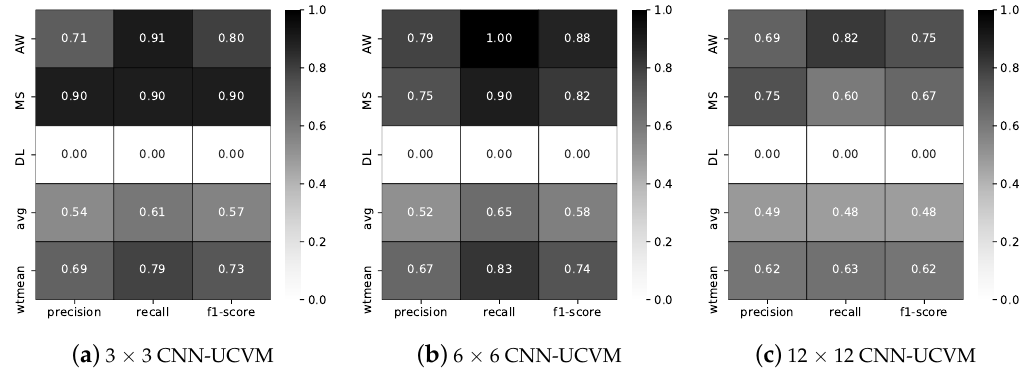
Figure 10. Validation statistics using field based vegetation observations for the CNN models trained using the UCVM dataset. (AW: Alder-Willow Shrub; DL: Dryas/Lichen Dwarf Shrub Tundra; MS: Mixed Shrub-Sedge Tussock Tundra-Bog; NV: Non-Vegetated; SW: Sedge-Willow-Dryas Tundra, and W: Water. avg: average score; wtmean: area weighted mean